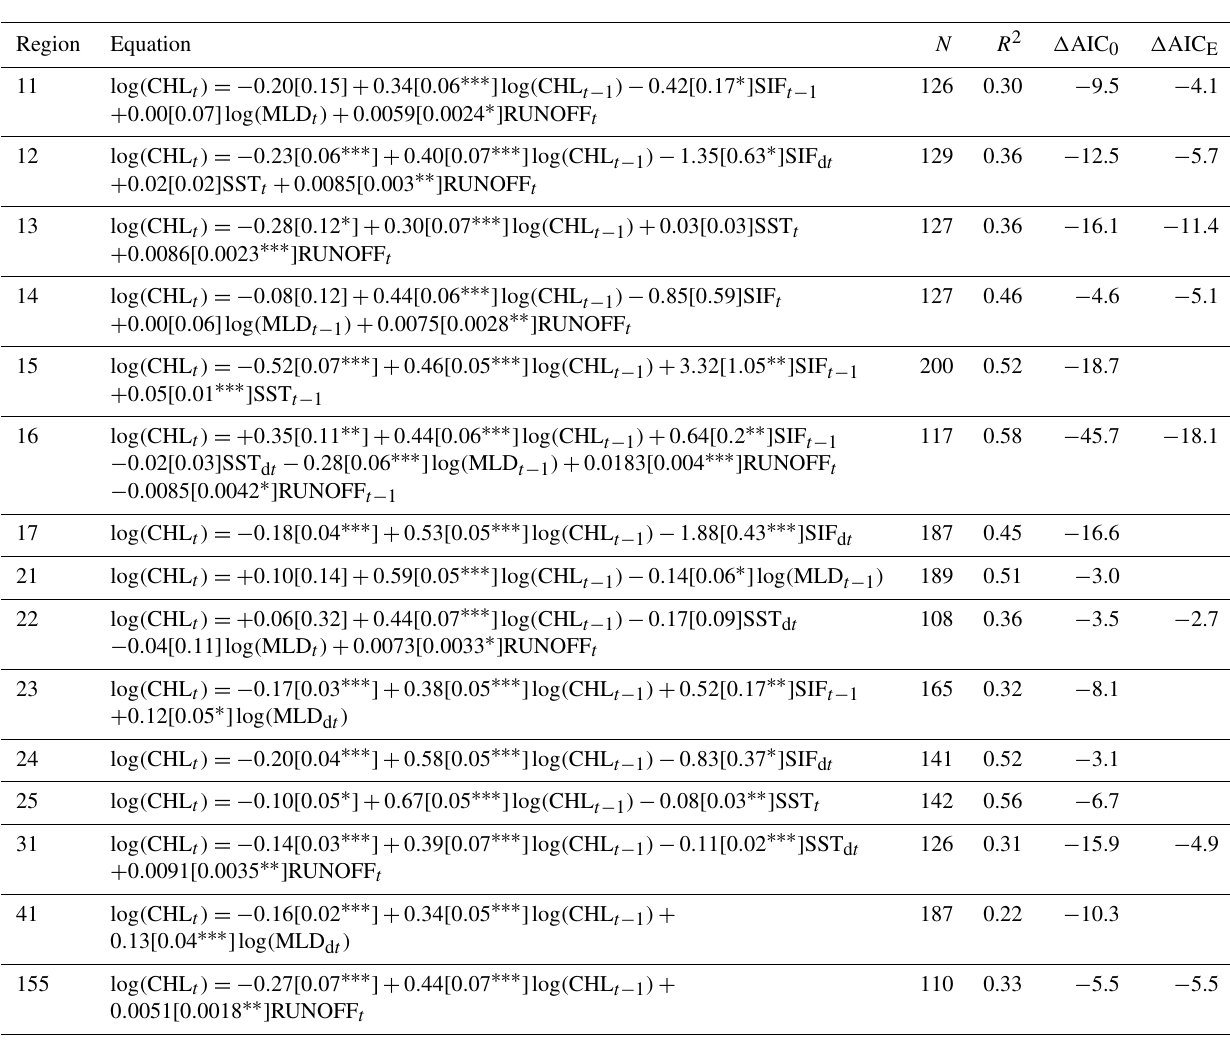
Table A1. Summary of models for regions within 0 to 10km from the coast. The model equations give parameter estimates with standard errors and statistical significance in brackets ( ∗ P < 0 . 05 ; ∗∗ P < 0 . 01 ; ∗∗∗ P < 0 . 001). N is the sample size, and R 2 is the proportion of variance explained. (cid:49) AIC 0 is the difference in the Akaike information criterion corrected for small sample size between the selected model and a null model with CHL in the previous time step, log ( CHL t − 1 ) , as the only predictor. (cid:49) AIC E is the difference in the Akaike information criterion corrected for small sample size between the selected model and an environmental model with RUNOFF excluded from the predictor